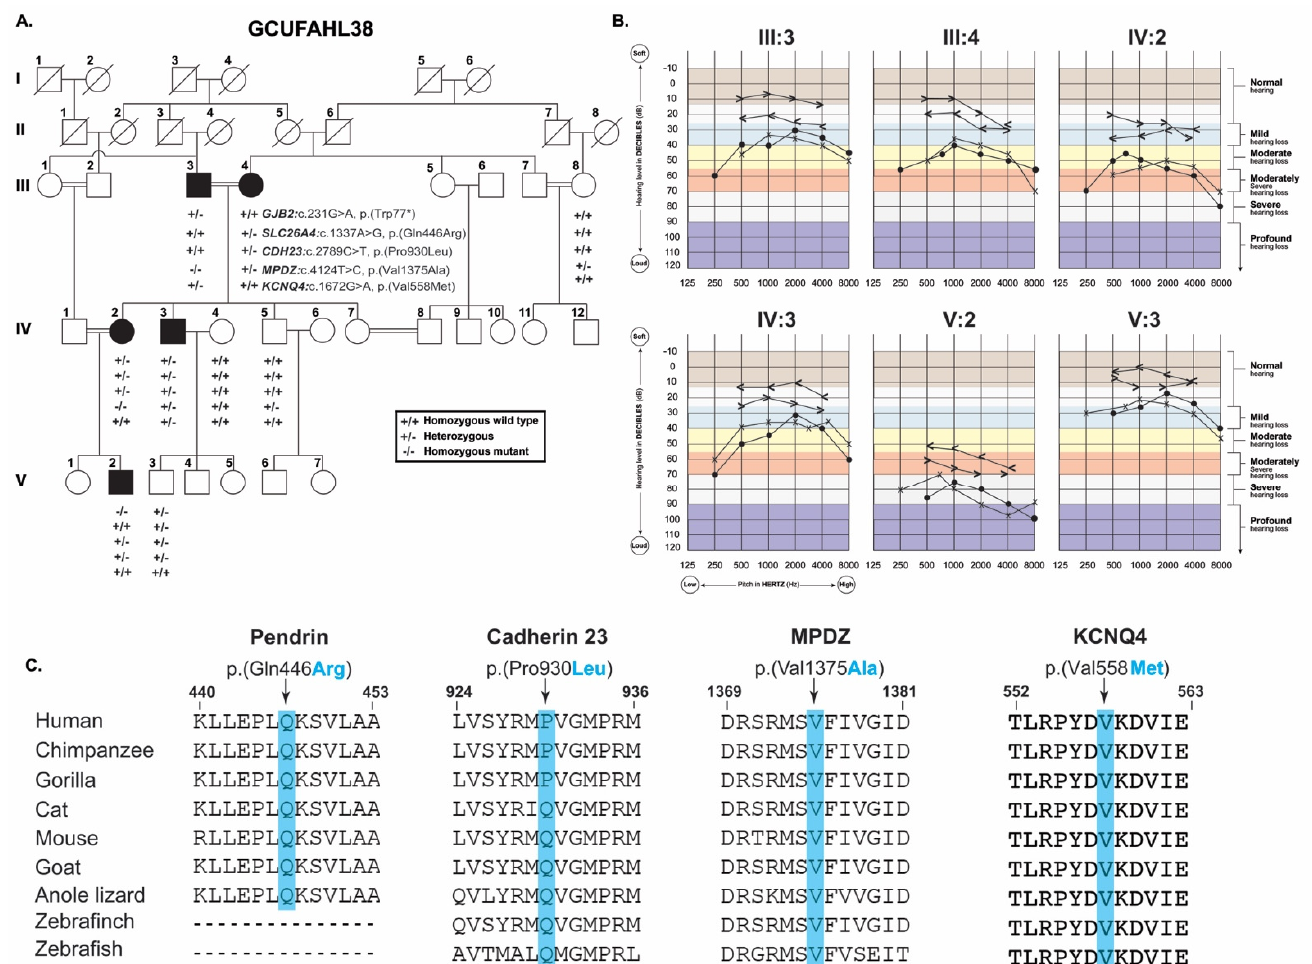
Figure 1. GCUFAHL38 family pedigree and audiometry. ( A ) Family pedigree affected with HL demonstrating inheritance pattern of five rare variants of five known deafness genes. Genotypes for each gene are shown in the form of haplotype under each individual checked for segregation analysis. Filled and empty circles represent affected and unaffected individuals, respectively; ( B ) Audiograms of affected individuals showing mild to severe–profound HL profile; ( C ) Multiple sequence alignment of hearing loss proteins amino acid residues found in study. Residues of interest are highlighted with blue bars.